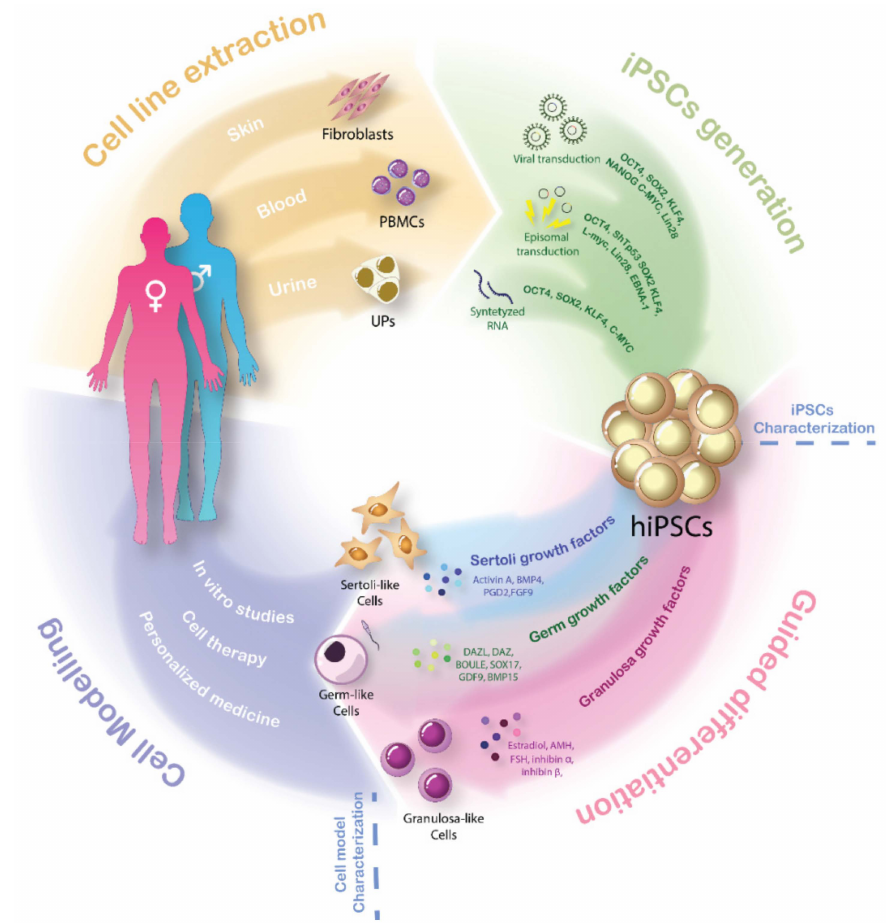
Figure 2. Cellular reprograming and guided di ff erentiation of hiPSCs: The scheme represents the four stages of the iPSCs-derived gonadal cell model generation for DSD patients. Isolation of fibroblasts, peripheral blood mononuclear cells or even urinary precursors directly from the patient have been considered as easy to obtain and patient-friendly cell sources. Up to date, three cellular reprogramming techniques are commonly used to generate hiPSCs from diverse cell sources: viral transduction of Yamanaka and Thomson reprograming factors; episomal transduction adding a EBNA1 factor and silencing expression of the TP53 gene; and synthetized RNA. Guided di ff erentiation by expression specific factors can force transformation of cell into Sertoli-like (BMP4, Activin A, PDG2 and FGF9) Granulosa-like (Estradiol, AMH, FSH, inhibin α and inhibin β ) or germ-like cells (DAZL, DAZ, BOULE, GDF9 and BMP15). Addition of both those factors into the culture medium and forced